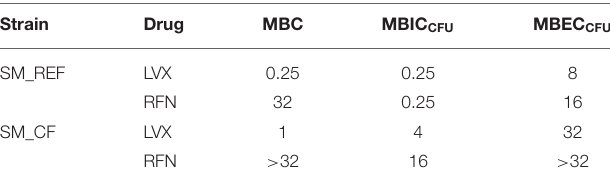
TABLE 2 | Efficacy of drugs to reduce cell numbers on planktonic cultures and biofilm forms of S. maltophilia